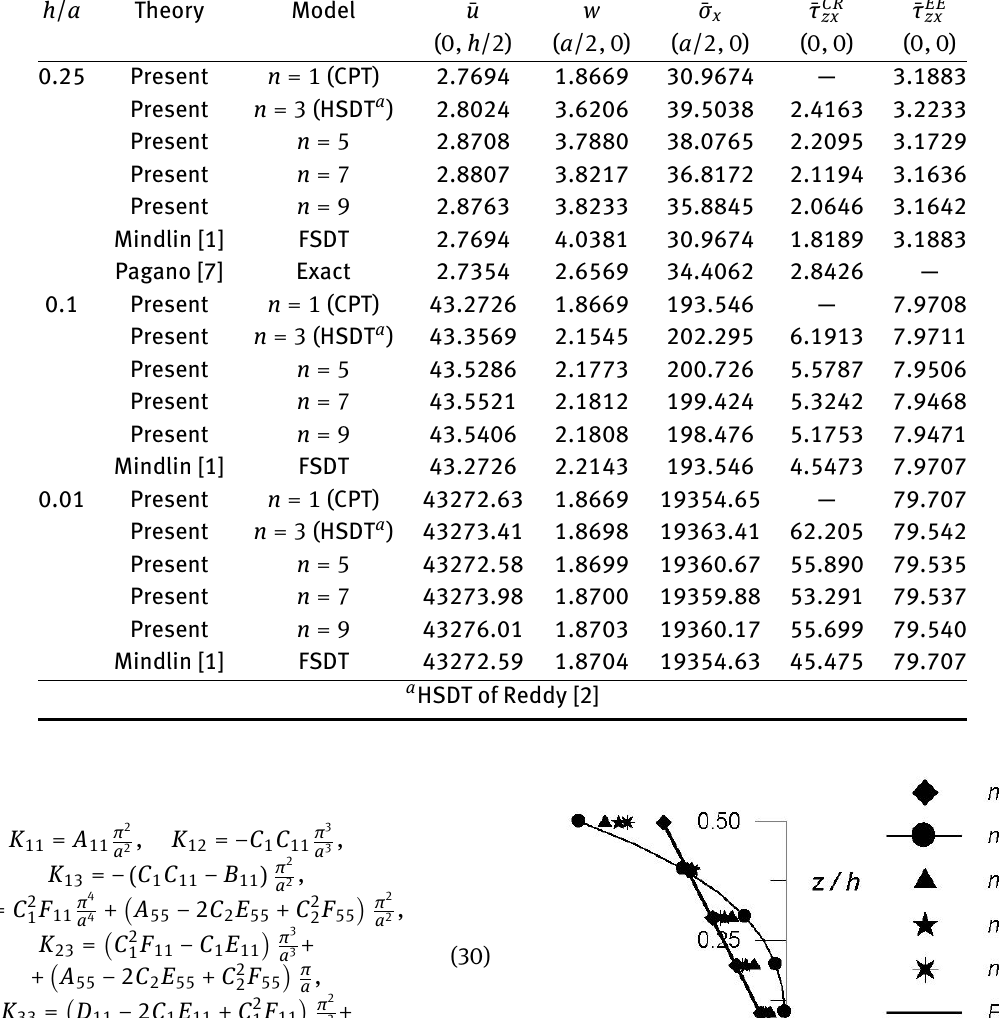
Table 2: Comparison of normalized displacements and stress for two layered (0 ∘ /90 ∘ ) un-symmterically laminated composite plates in cylindrical bending (Material 2).